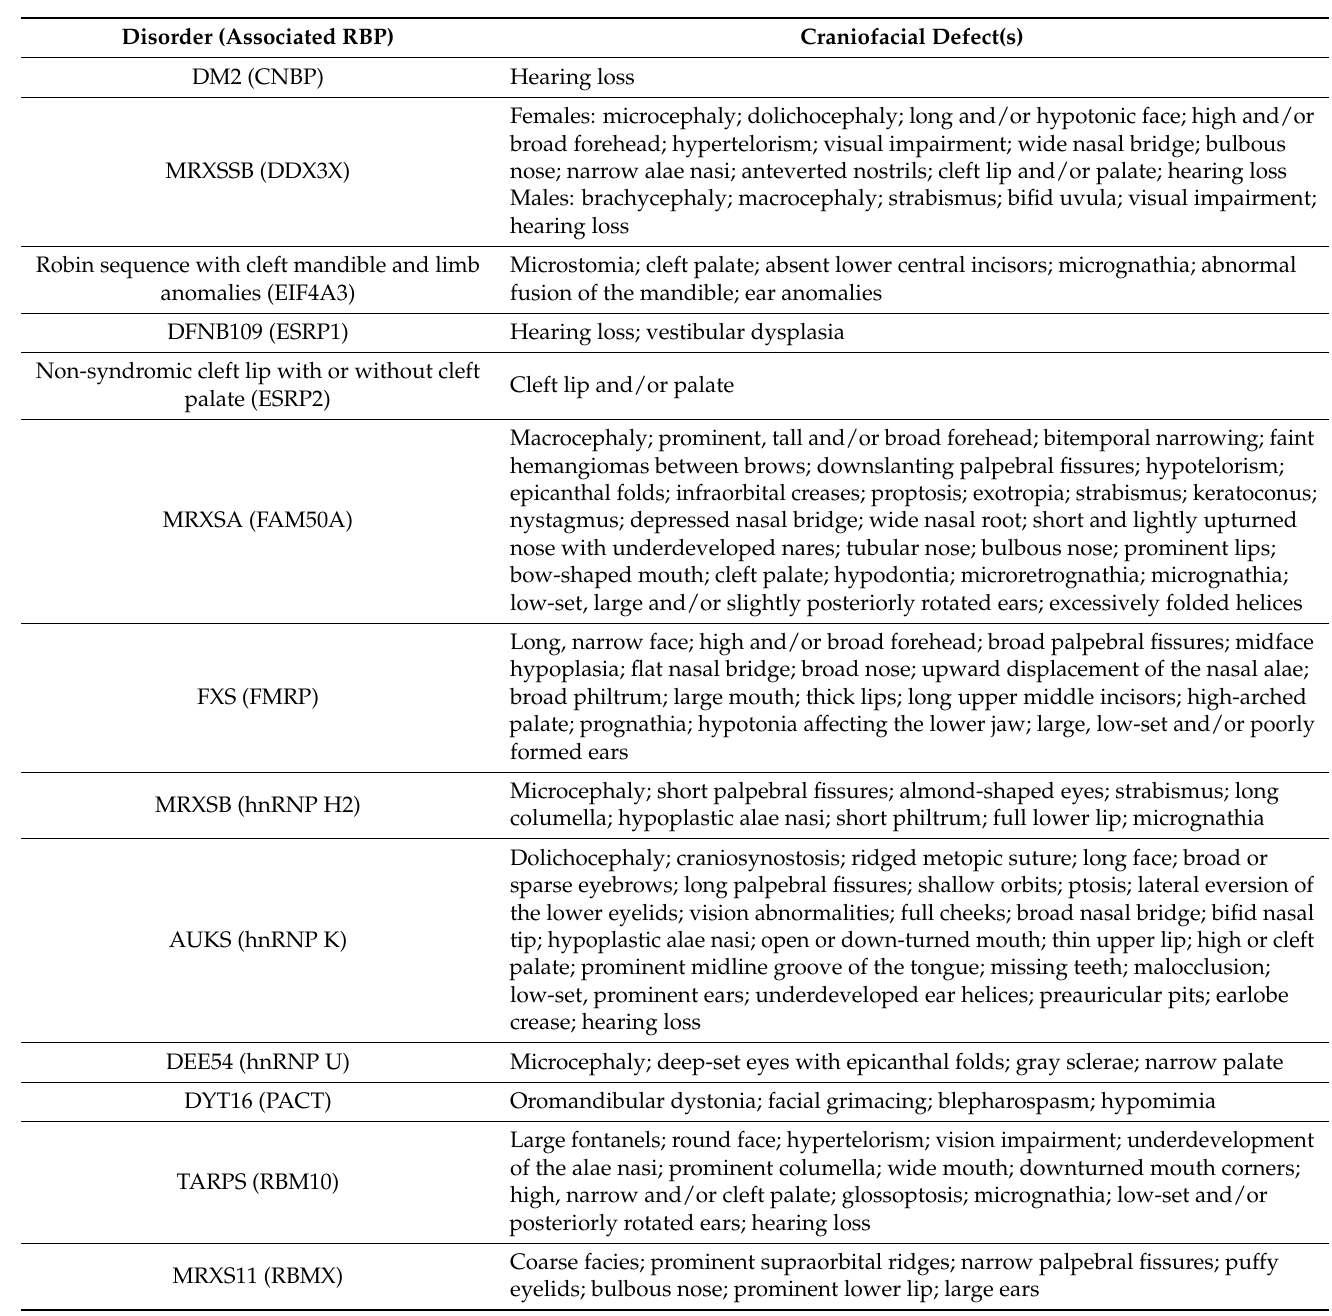
Table 1. Craniofacial defects associated with mis-expression of human